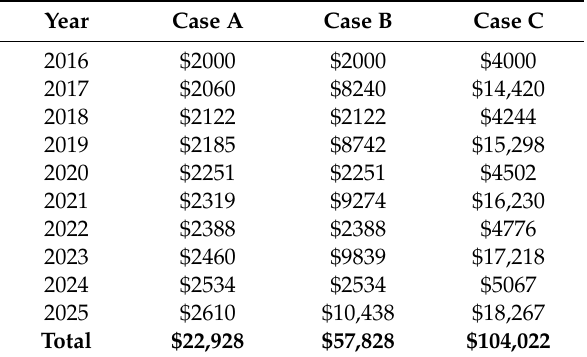
Table 15. Failure event